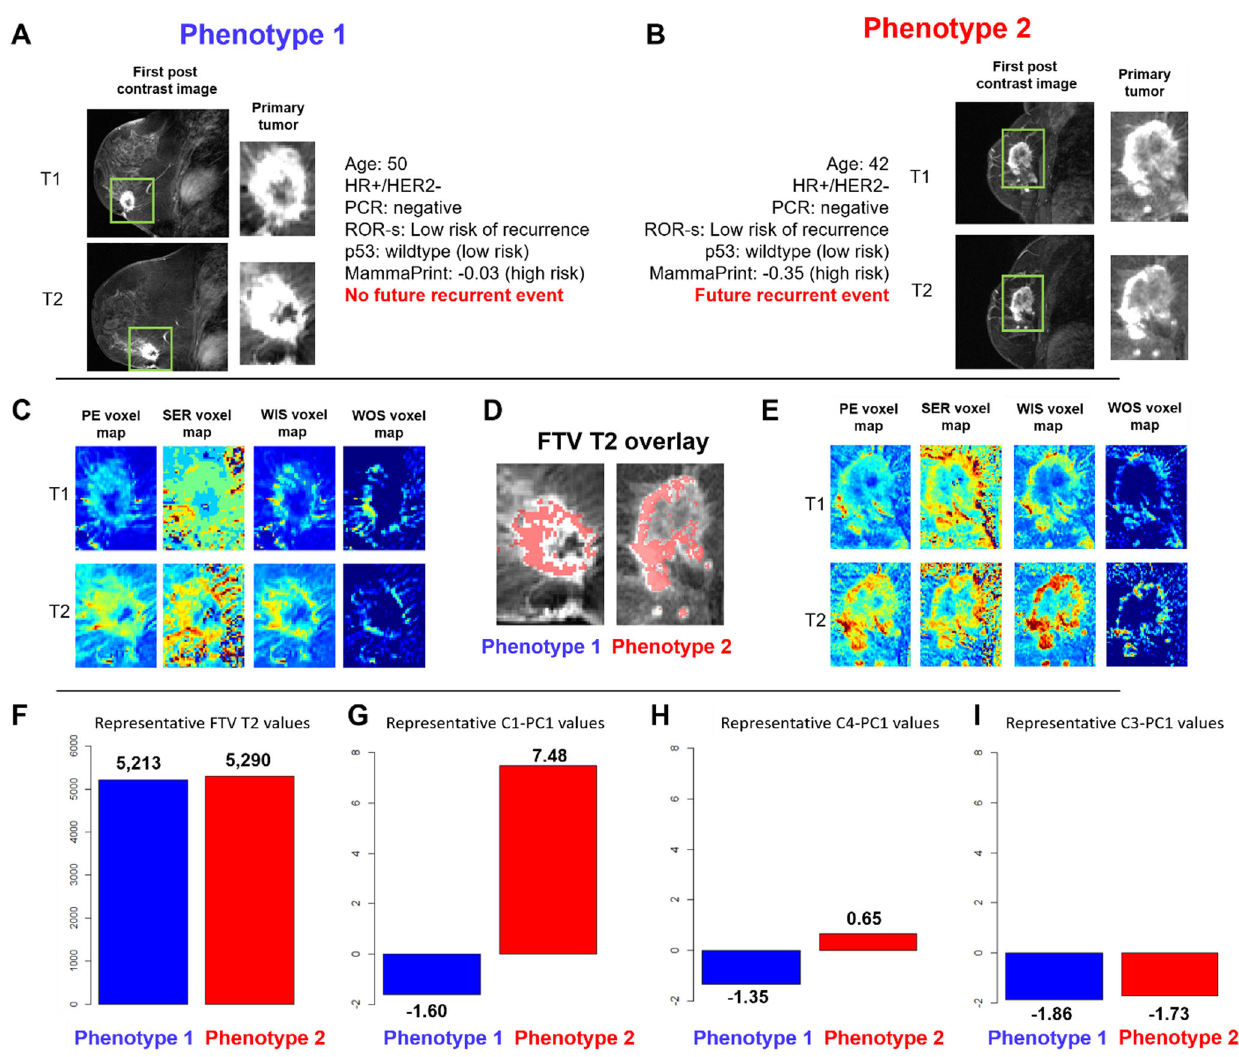
Fig. 7 Representative Tumors from Each Phenotype. Representative tumors from Phenotype 1 (early decrease in intratumor heterogeneity) and. Phenotype 2 (early increase in intratumor heterogeneity) shown in DCE-MRI scans at T1 and T2 from the discovery cohort. A Representative 2D DCE-MRI slice and tumor region for T1 and T2 images from a woman, age 50, with an HR + /HER2-, ROR-S low risk, p53 wildtype (low risk), and MammaPrint score of − 0.03 (high risk) tumor with no pCR and no future event of recurrence assigned to Phenotype 1. B Representative 2D DCE-MRI slice and tumor region for T1 and T2 images from a woman aged 42, with an HR + /HER2-, ROR-S low risk, p53 wildtype (low risk), and MammaPrint score of − 0.35 (high risk) tumor with no pCR and a future event of recurrence assigned to Phenotype 2. C Representative 2D images of peak enhancement (PE), signal enhancement ratio (SER), wash-in slope (WIS), and wash-out slope (WOS) voxel-wise maps for T1 and T2 for the tumor in phenotype 1. D Functional tumor volume at T2 (FTV 2 ) overlay for these representative tumors from phenotype 1 and 2. E Representative 2D images of PE, SER, WIS, and WOS voxel-wise maps for T1 and T2 for the tumor in phenotype 2. F FTV 2 values for each representative tumor. Values for features ( G ) C1-PC1, ( H ) C4-PC1, and ( I ) C3-PC1, for each representative tumor. These representative cases provide an example where imaging characterizations of changes in each tumor ’ s heterogeneity provided a strati fi cation related to future outcomes. In this example, established clinical covariates did not provide such strati fi